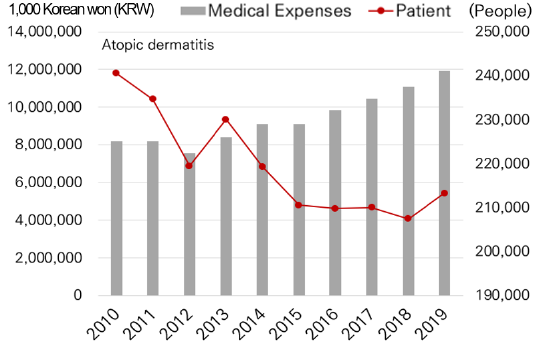
Figure 6. Atopic dermatitis patients and medical expenses.